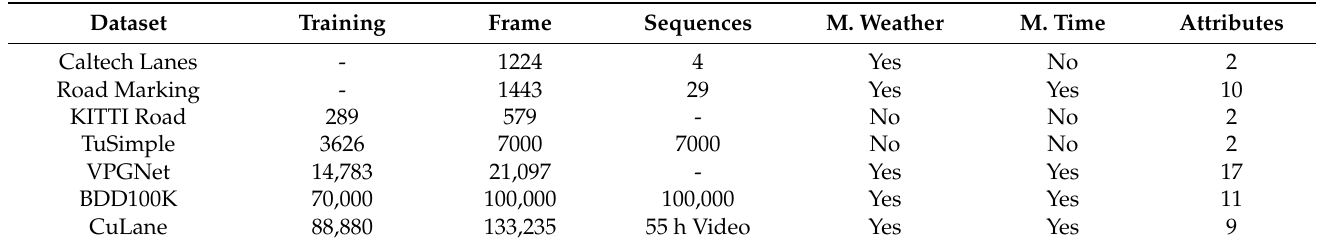
Table 1. Comparison among different lane line